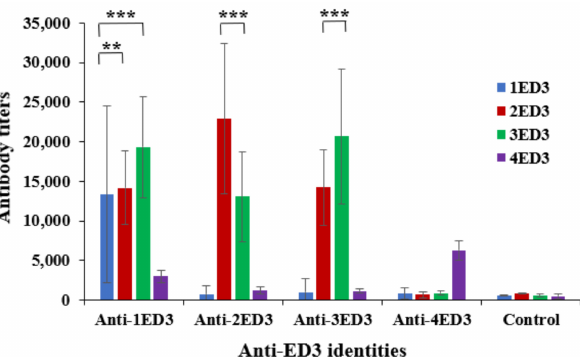
Figure 1. The serospecificity, sero-cross-reactivity, and immunogenicity of DENV1–4 ED3s in mouse models. Four different groups of mice were injected with four different ED3s in complete adjuvants in BALB/c mice. Anti-ED3 IgG titers on day 28 following 1st immunization are shown. First, all four ED3s were immunogenic and generated serotype-specific anti-ED3 IgG responses. Second, anti-1ED3 IgG was 1ED3-2ED3-3ED3 cross-reactive, and anti-2ED3 and anti-3ED3 were 2ED3-3ED3 cross-reacting. In contrast, anti-4ED3 was completely serotype-specific (4ED3-specific) with no-cross- recognition of other ED3s. Asterisks represent the comparisons using Dunnett’s multiple comparison test; ** p < 0.001 and *** p <